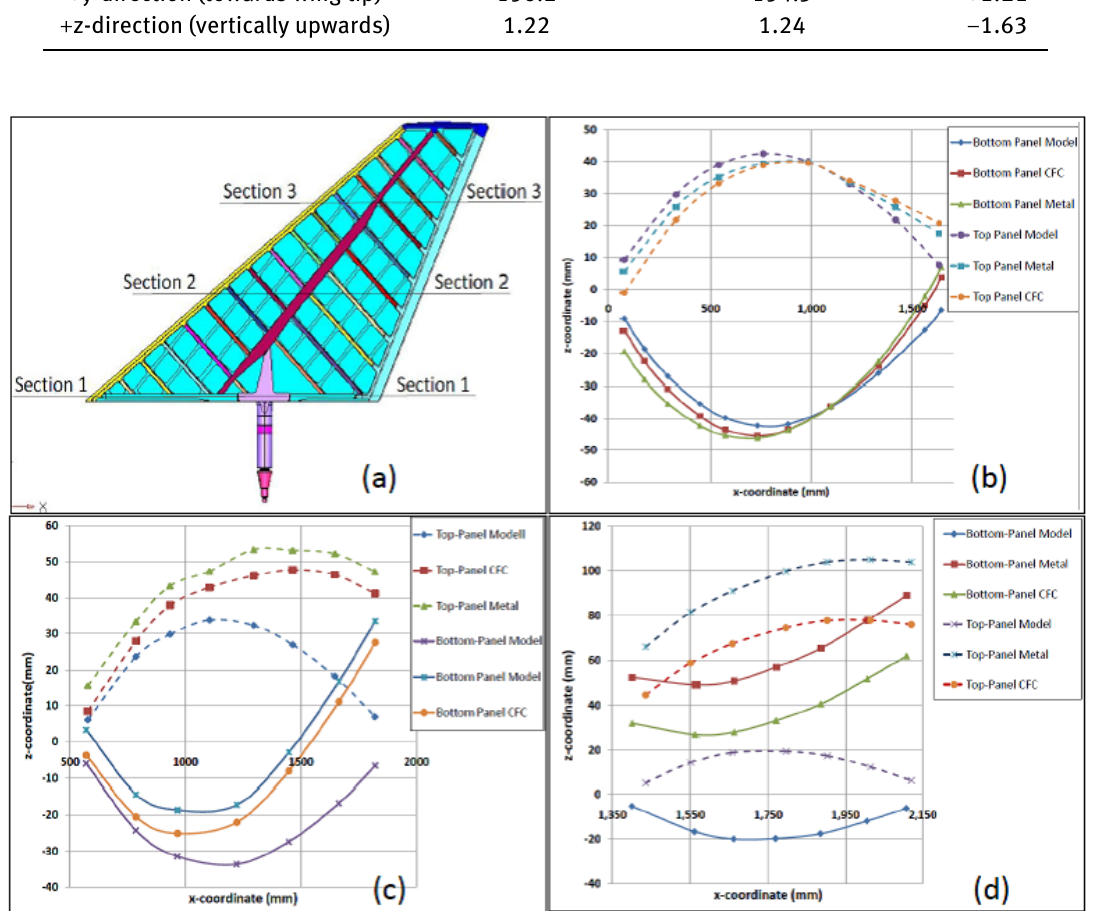
Figure 9: (a) Sections of Camber and Deformations at Camber Section (b) 1, (c) 2, (d)